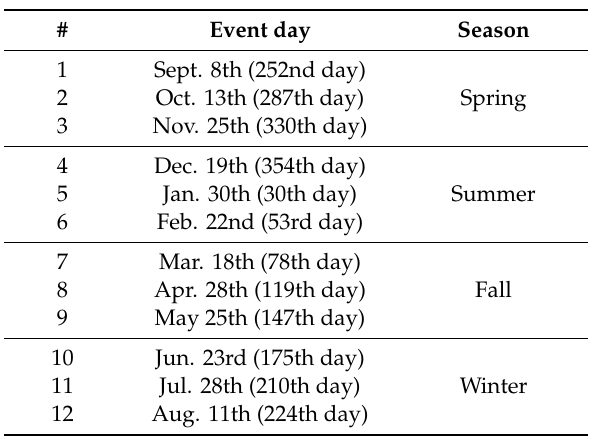
Table 2. Event Days in